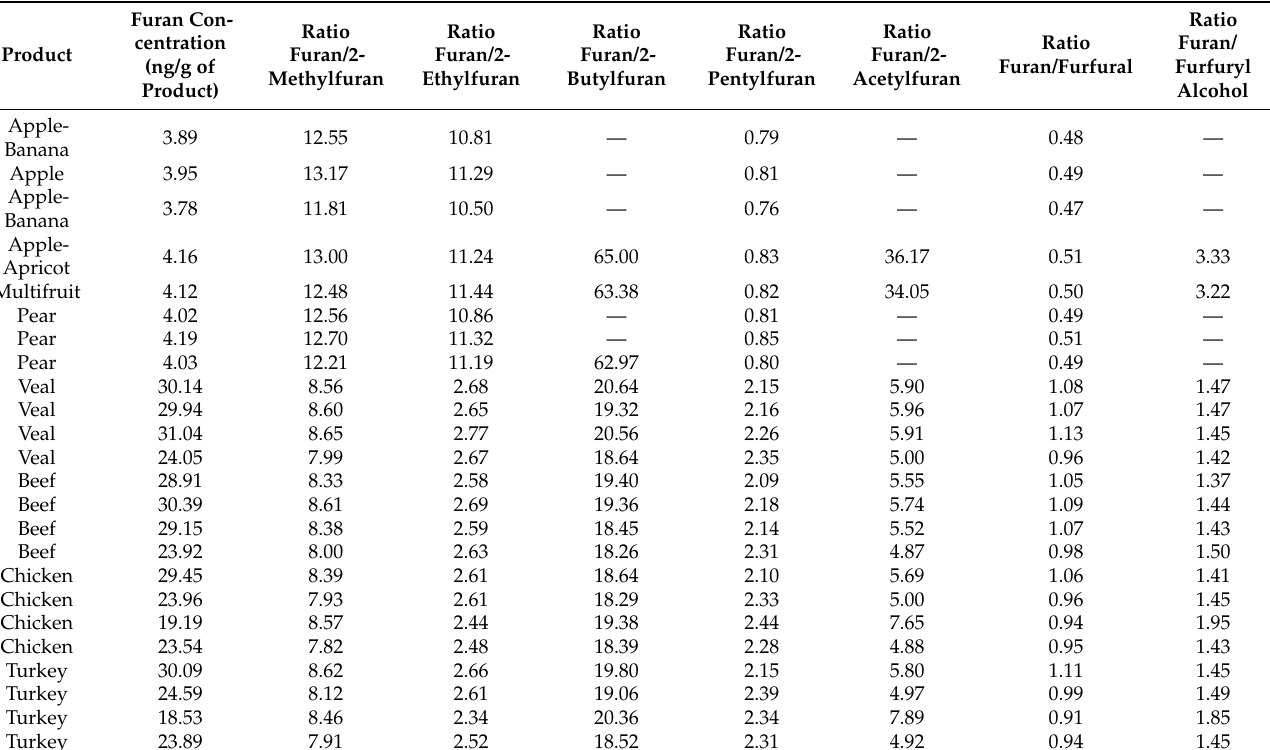
Table 1. Furan concentration and ratios furan/furan derivatives of different jarred baby food. Data source: Condurso et al. 2018. Furan Con- centration Product Apple- Banana